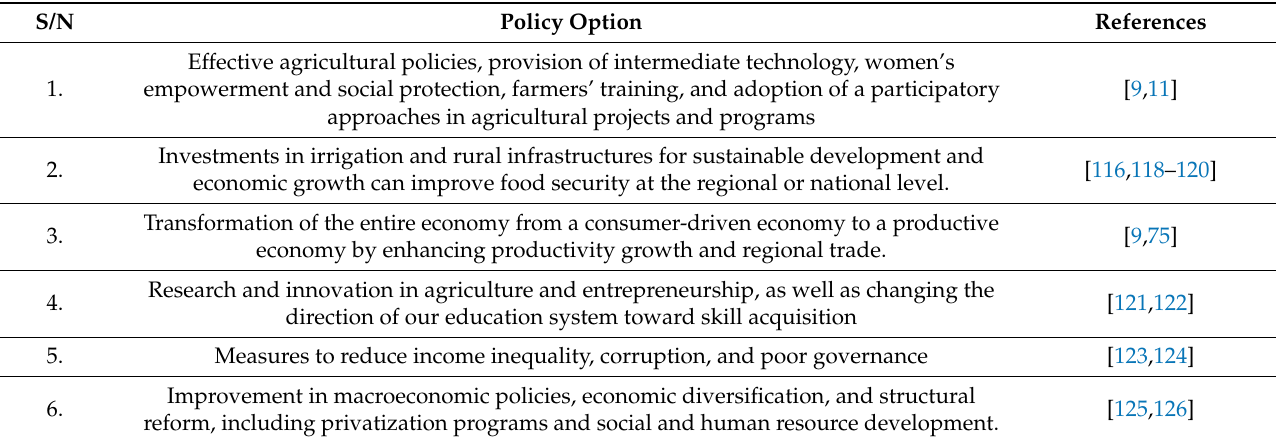
Table 1. The Gateway to Sustainable Food Security in the SSA